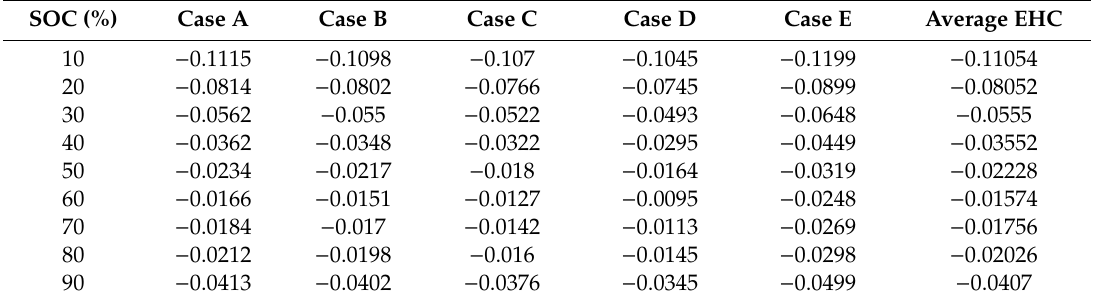
Table 2. Entropic heat coe ffi cient (EHC) (mV / ◦ C) at di ff erent state of charge (SOC) and